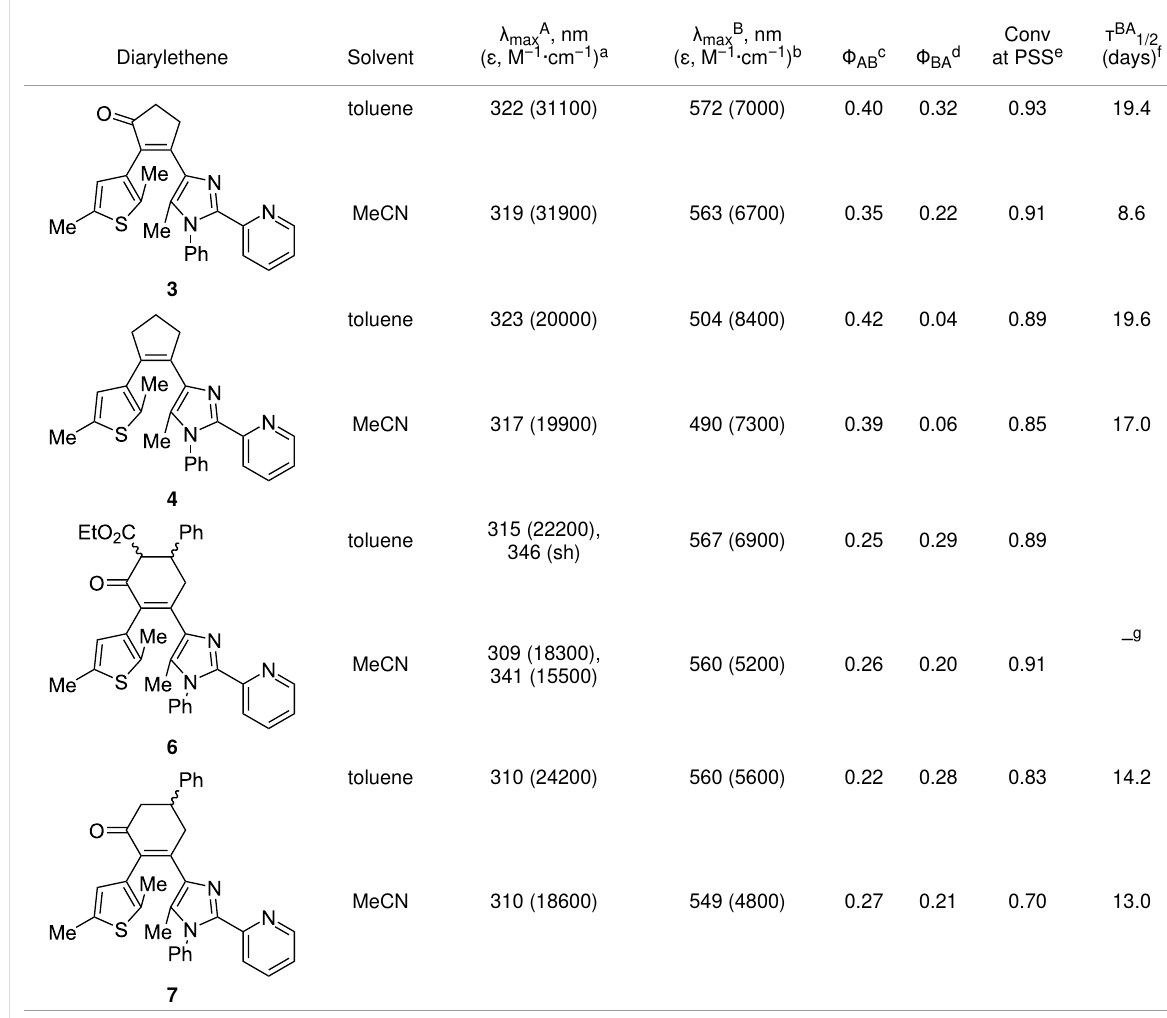
Table 1: Spectroscopic and photochemical properties of photochromic ligands.